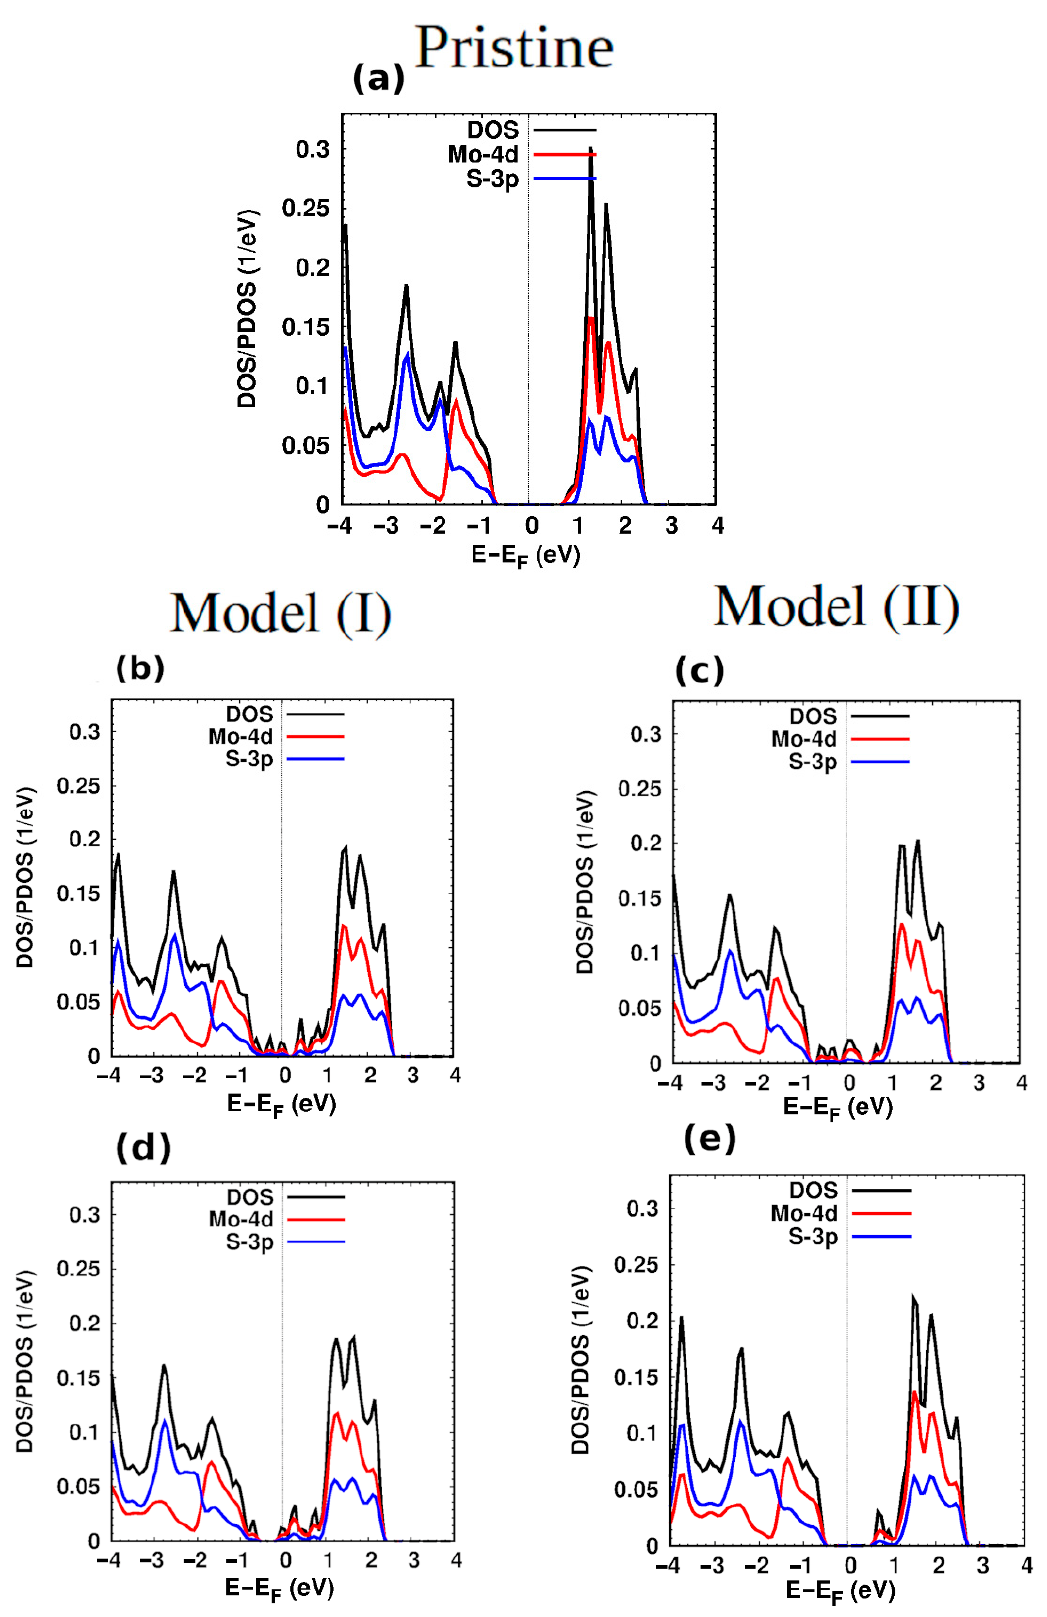
Figure 2. DOS/PDOS of ( a ) pristine MoS 2 , ( b ) G@MoS 2 model I, ( c ) G@MoS 2 model II, ( d ) h-BN@MoS 2 model I, and ( e ) h-BN@MoS 2 model II.